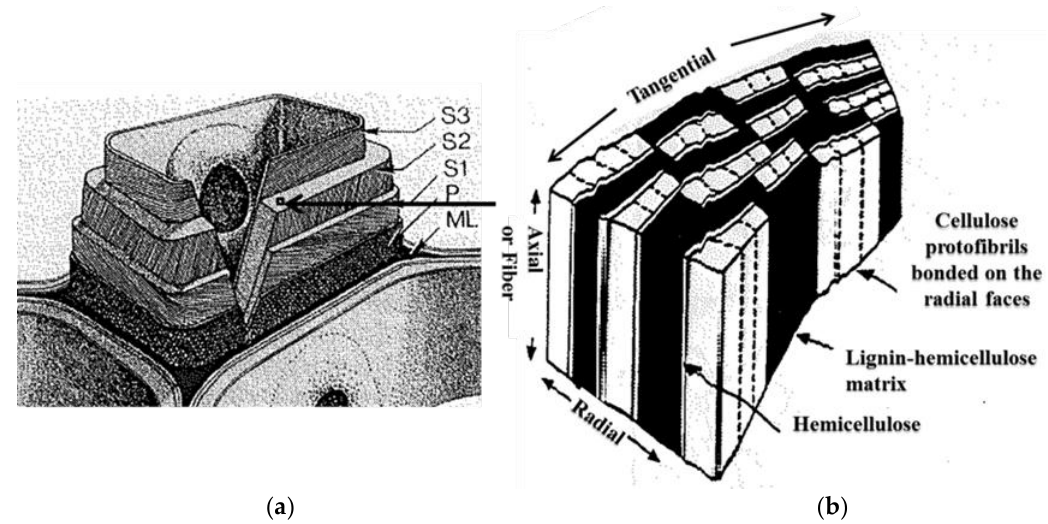
Figure 5. ( a ) Illustration of three main regions in the cell wall: the middle lamella (ML), the primary wall (P), and the three layers of the secondary wall (S1, S2 and S3) [44]; ( b ) Proposed ultrastructural model of the arrangement of hemicellulose, cellulose and lignin in the S2 layer [32].